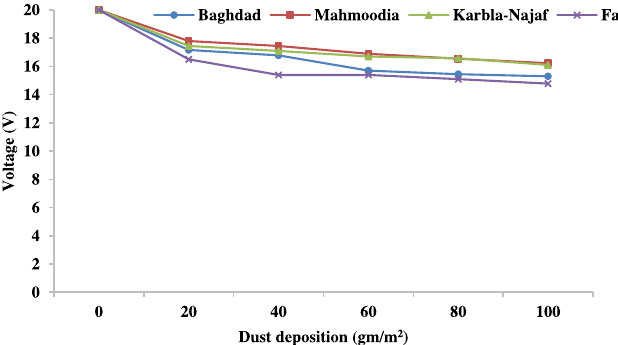
Fig. 4. Voltage reduction due to dust accumulation on PV surface for the tested dust types.